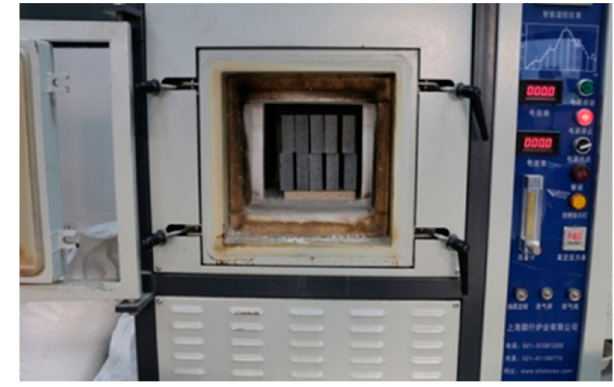
Figure 3. MXQ1700 heating device.